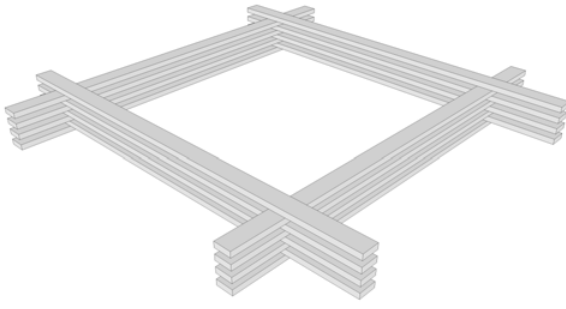
Figure 1. Quadruple layer gridshell